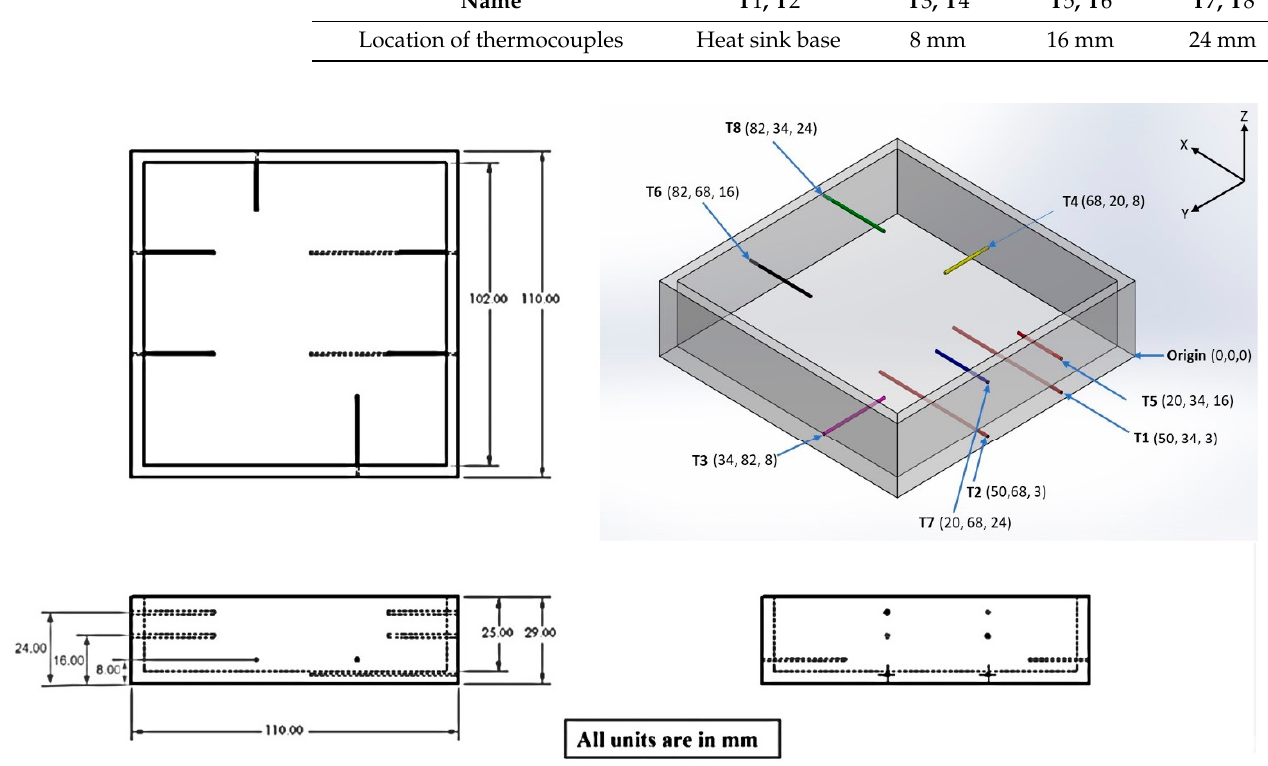
Figure 11. Various isometric views of heat sink depicting thermocouples